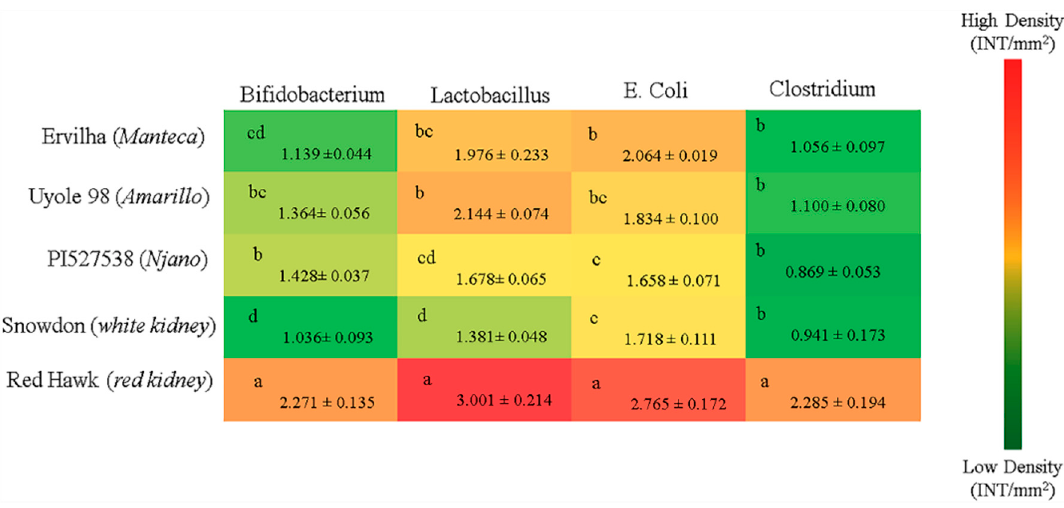
Figure 4. Genera and species-level bacterial populations (AU) from cecal contents after 6 weeks of consuming bean based diets. Values are means ± SEM (n = 6 per treatment group). Means sharing the same letter in each column are not significantly different at p ≤ 0.05.